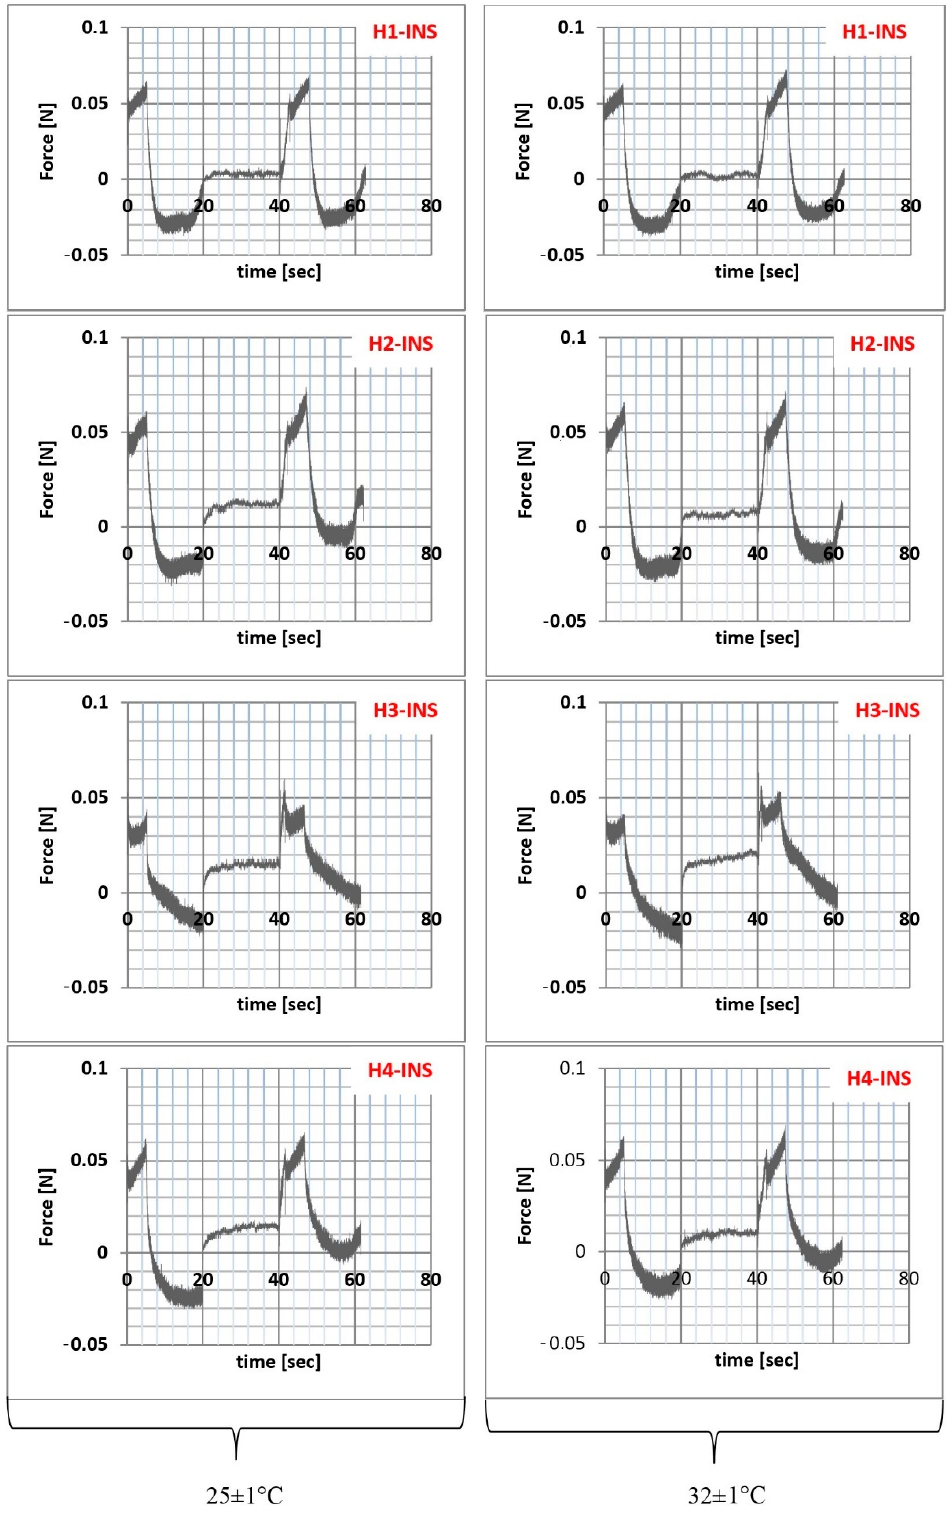
Figure 7. Texture profile analysis (TPA) of hydrogel samples at 25 ± 1 °C and 32 ± 1 °C. The percentage of relaxation is determined by the elasticity index. Hydrogels with a higher %R are characterized by lower stiffness [50,51]. The highest %R value was recorded